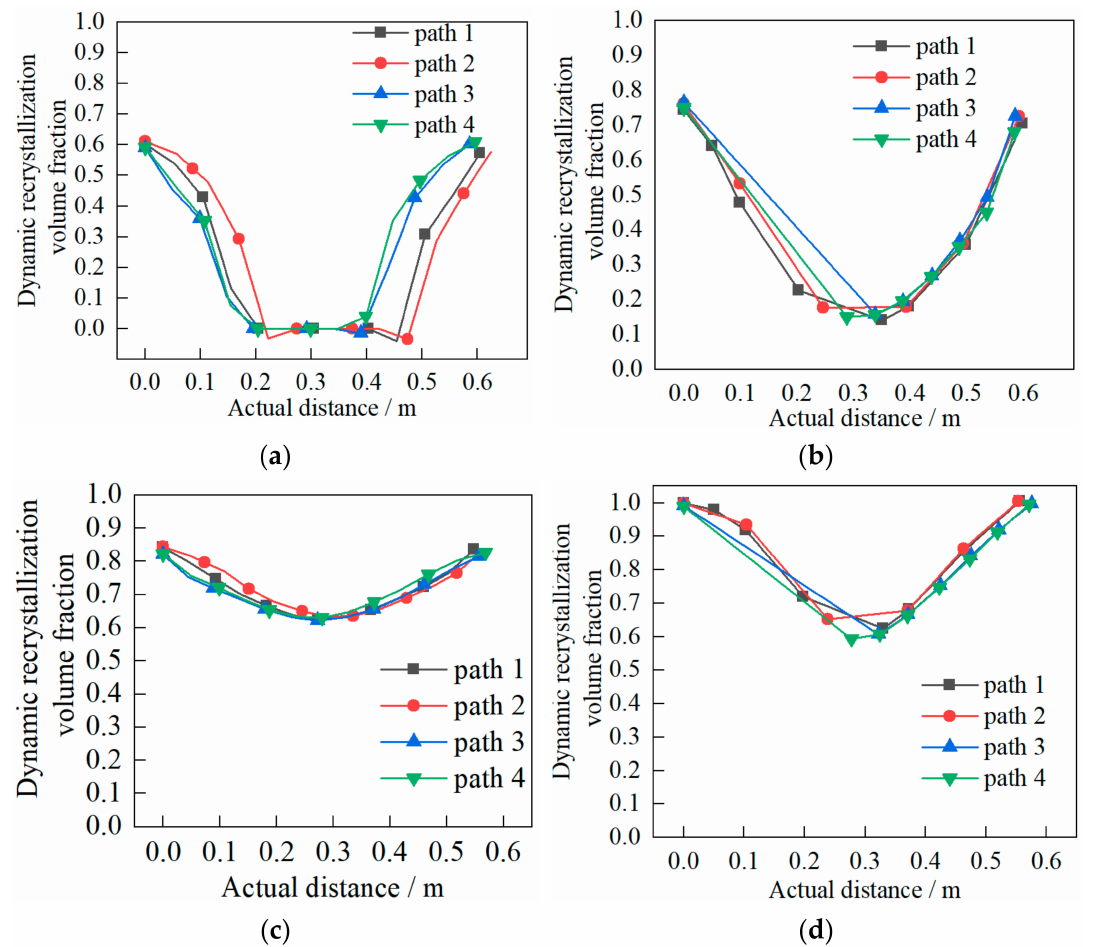
Figure 18. Evolution characteristics of recrystallization volume fraction in two passes of rolling: ( a ) first pass rolling, without shear effect; ( b ) first pass rolling, with shear effect; ( c ) second pass rolling, without shear effect; ( d ) second pass rolling, with shear